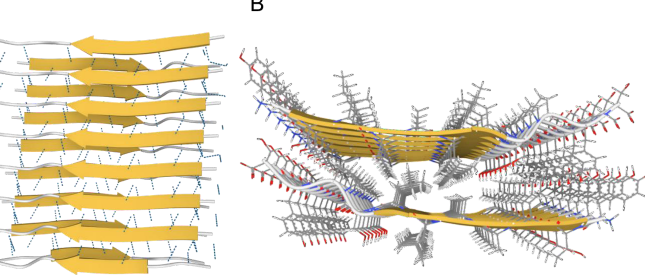
Figure 1. The cross- β conformation of amyloids. ( A ). Side-view showing the intermolecular β -sheets stabilized by hydrogen bonds (dotted lines). ( B ). Top-view showing the dry steric zipper between the two opposing β -sheets with interdigitating sidechains. Images created using Mol* [21] from PDB structure 2M5N from paper by Fitzpatrick et al., 2013 [22]. Another major difference between native protein folding and the cross- β confor- mation of amyloids is that the interdigitation of side chains between β -sheet ladders gen- erally deprives amyloids from any characteristic domains. Additionally, the extensive, hi- erarchical self-interaction (ladders within zippers, zippers within protofilaments, proto- filaments within fibrils, and fibrils within plaques) makes amyloids very stable and, con- sequently, extremely difficult to solubilize and relatively inert. The aggregated, plaque nature of amyloids is, again, in contrast with functional fibrous proteins which assemble in well-defined networks by accessory proteins [23]. The difference between functional fibrous proteins and amyloids is summarized in Table 1. Table 1. The differences between fibrous proteins and amyloid fibrils. Fibrous Proteins